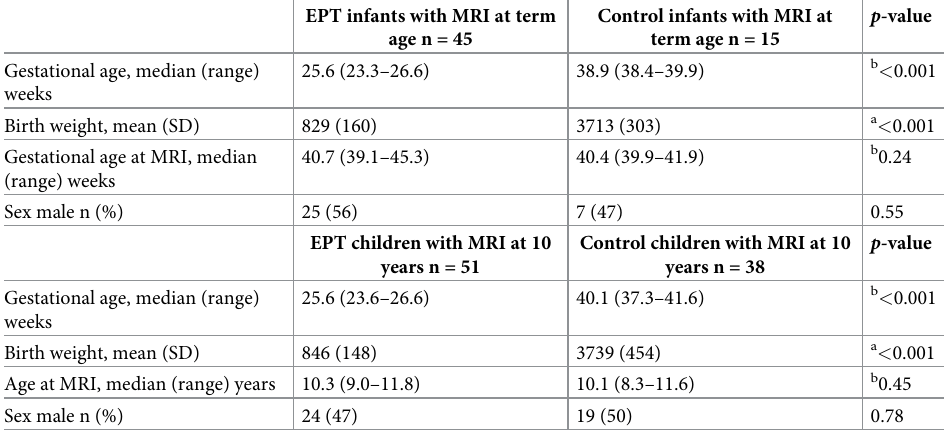
Table 1. Characteristics for included EPT and control infants and children. EPT infants with MRI at term age n =